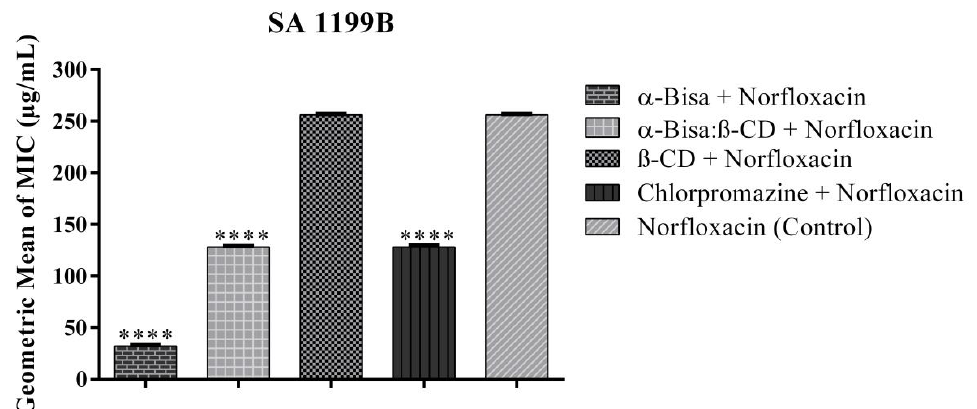
Figure 2. Effect of the compounds associated with norfloxacin against Staphylococcus aureus